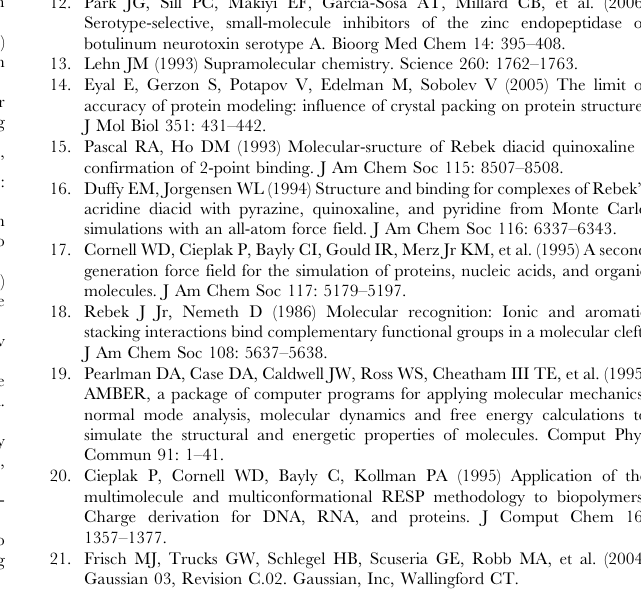
Figure S8 Chemical structures of the 161 host-guest complexes. Found at: doi:10.1371/journal.pone.0000531.s010 (0.12 MB TIF) Figure S9 Chemical structures of the 161 host-guest complexes. Found at: doi:10.1371/journal.pone.0000531.s011 (0.12 MB TIF) Figure S10 Chemical structures of the 161 host-guest com- plexes. Found at: doi:10.1371/journal.pone.0000531.s012 (0.12 MB TIF) Figure S11 Chemical structures of the 161 host-guest com- plexes. Found at: doi:10.1371/journal.pone.0000531.s013 (0.20 MB TIF) Figure S12 Chemical structures of the 161 host-guest com- plexes. Found at: doi:10.1371/journal.pone.0000531.s014 (0.12 MB TIF) Figure S13 Chemical structures of the 161 host-guest com- plexes. Found at: doi:10.1371/journal.pone.0000531.s015 (0.10 MB TIF)